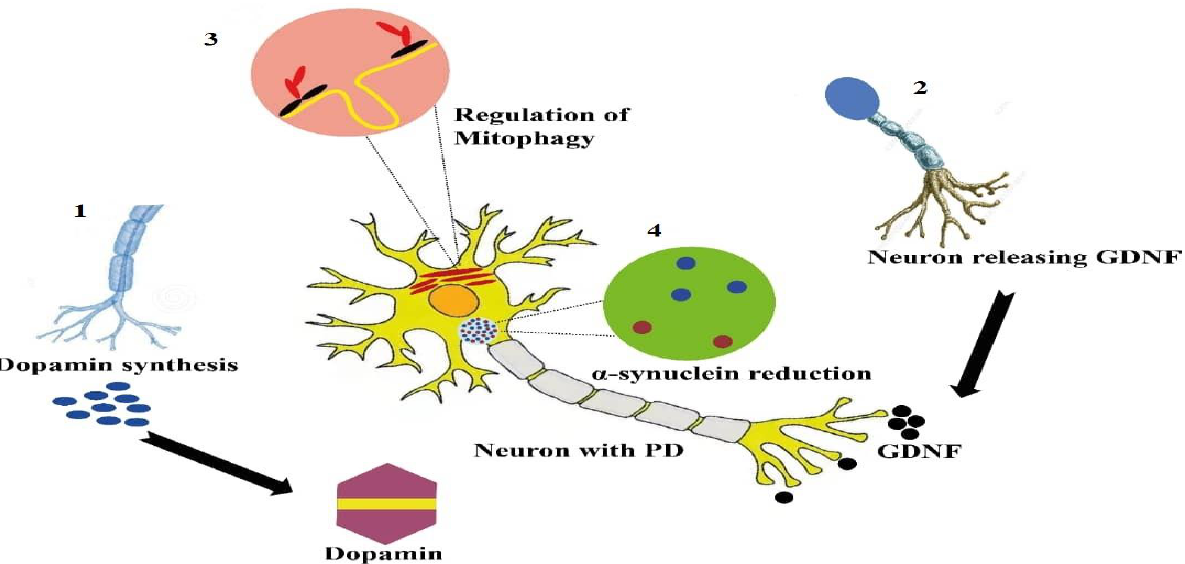
Figure 2. Four categories of gene-editing strategies for PD based on the therapeutic target are (1) enhancement of dopamine synthesis, (2) increase in the availability of trophic factors and neuromodulation, (3) activation of mitophagy, and (4) α -synuclein clearance in the brain.